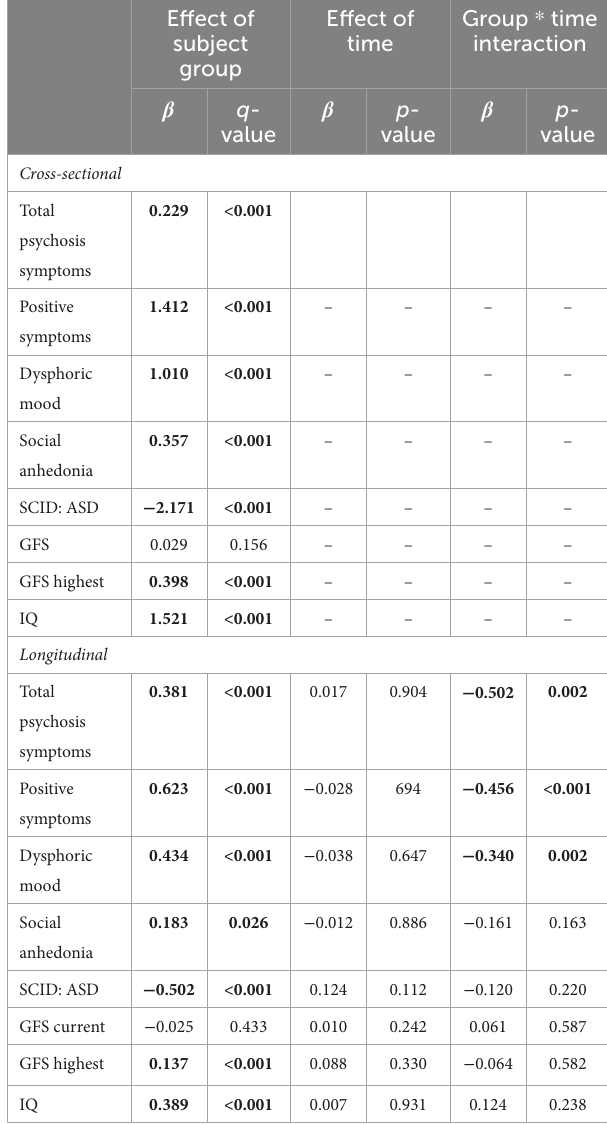
TABLE 5 Differences in neurobehavioral measures between 22qDel (reference group) and NAPLS CHR subject